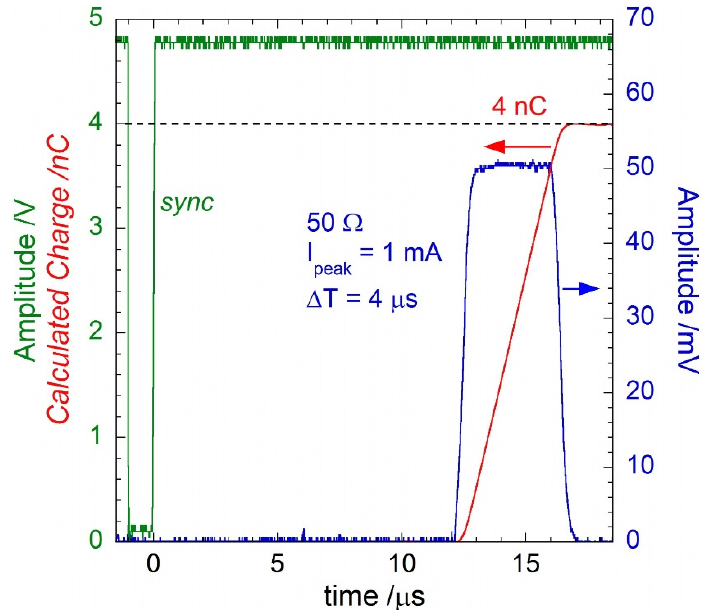
Figure 2. Example of a pulsed current signal (blue trace) generated by the Keithley 6221 current source. The instrument was programmed to generate a 1 mA pulse (4 µs wide) 12 µs after the sync source. The instrument was programmed to generate a 1 mA pulse (4 µ s wide) 12 µ s after the (green trace) signal rising edge. The current signal was acquired by a 50 Ω -terminated digital sync (green trace) signal rising edge. The current signal was acquired by a 50 Ω -terminated digital oscilloscope. In red, the calculated charge over time of the current pulse. oscilloscope. In red, the calculated charge over time of the current